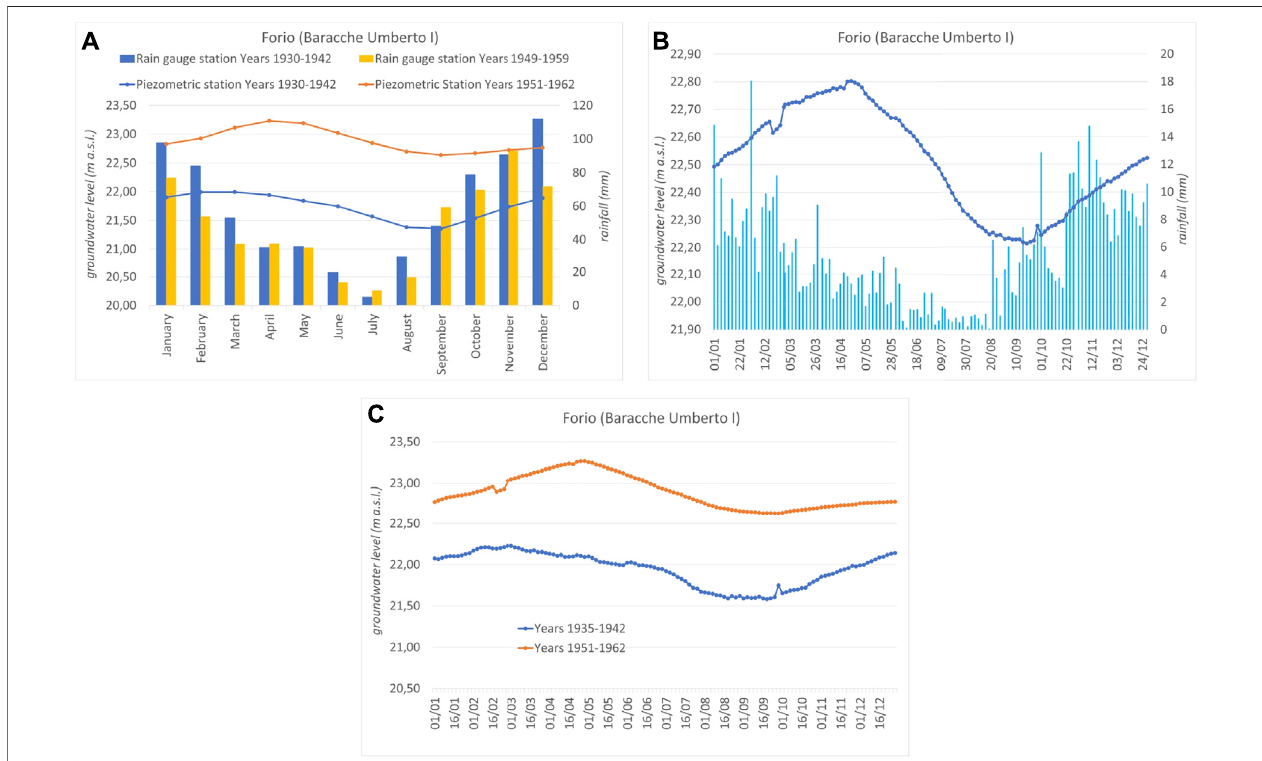
FIGURE4 | Analysisofthe groundwater level fl uctuations measured in the National Hydrographicand Mareographic monitoring well “ Forio (Baracche Umberto I) ” : (A) comparison between the average monthly groundwater level and rainfall; (B) comparison between the average daily groundwater level and rainfall observed from 1935 to 1962; (C) comparison of the groundwater fl uctuations for speci fi c time periods. The well location is in Figure 2 .